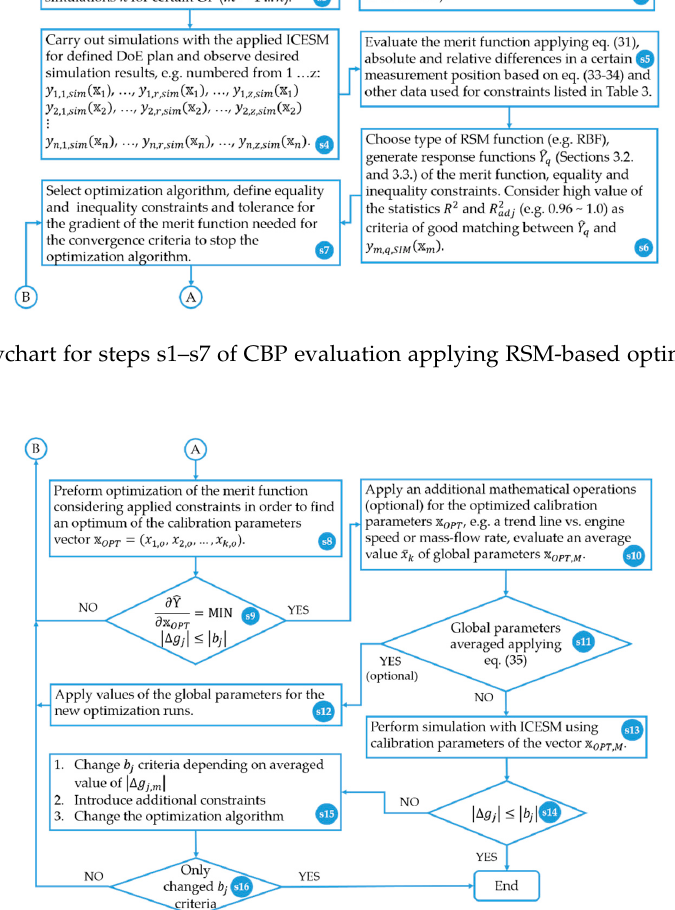
Figure A2. Flowchart for steps s8–s16 of CBP evaluation applying RSM ‐ based optimizations in one calibration loop.